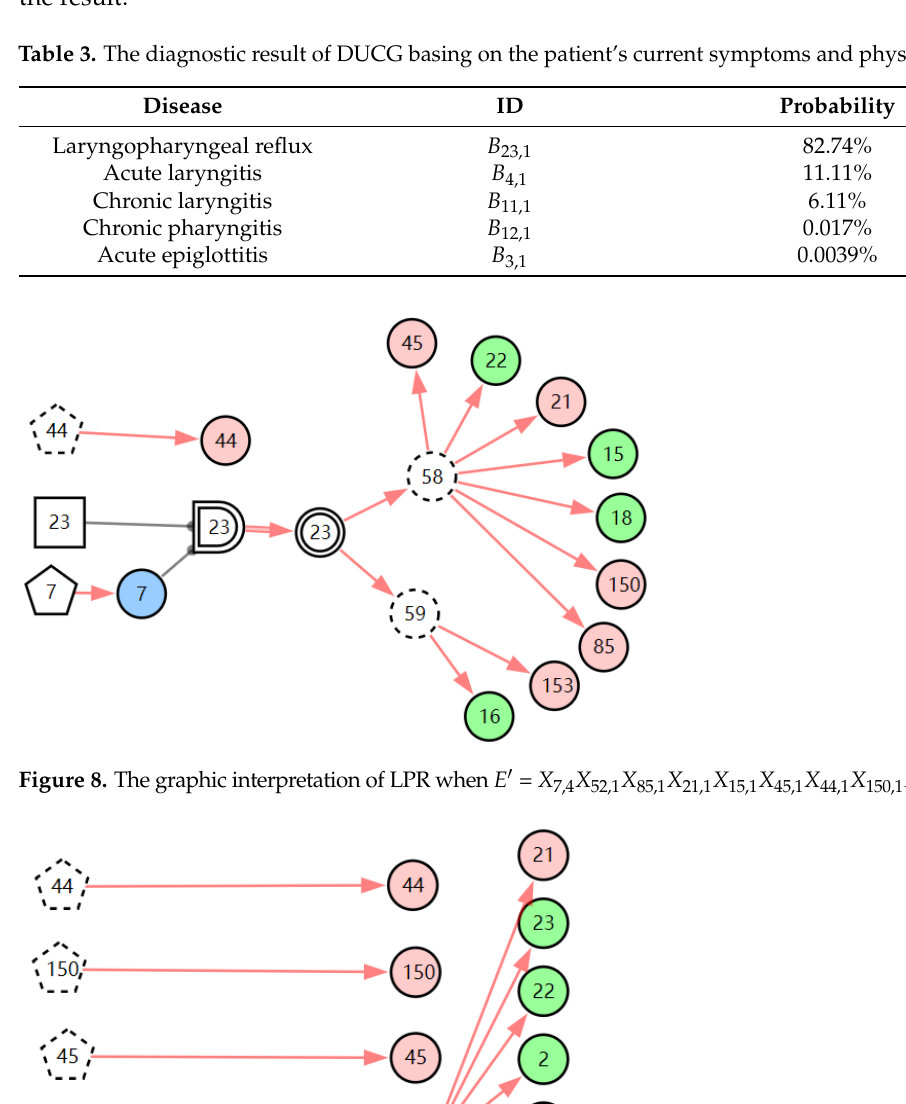
Figure 7. The graphic interpretation of LPR when E ’ = X 7,4 X 52,1 X 85,1 X 21,1 X 15,1 X 45,1 X 44,1 X 150,1 X 5,1 .